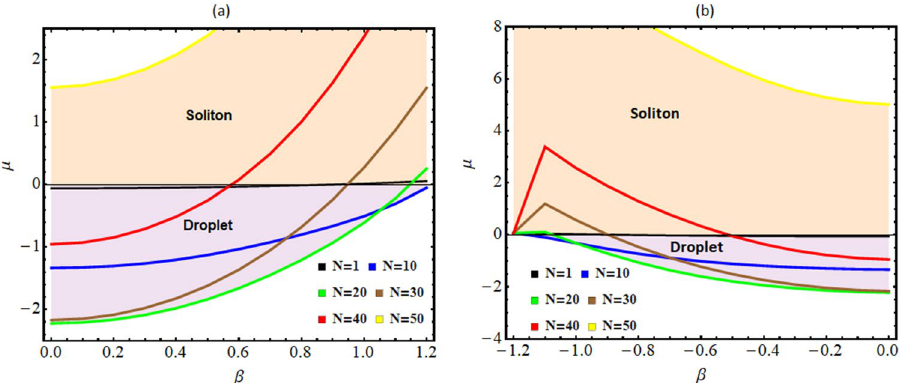
1 , 10, 20, 30, 40 and 50) and the BOL Figure 4. The figure illustrates the energy as a function of particle ( N = 1.2 , and ( b ) 1.2 β < 0 . Here, the magnitude of physical parameters: potential depth β with ( a ) 0 < β ≤ − ≤ 0.84 , G 1 1 , G 1 0.999999999 , E 1 , k 2 / 9 . A clear separation of droplet and soliton phase is γ 0 = = − = − = = − indicated with increasing magnitude of N and β